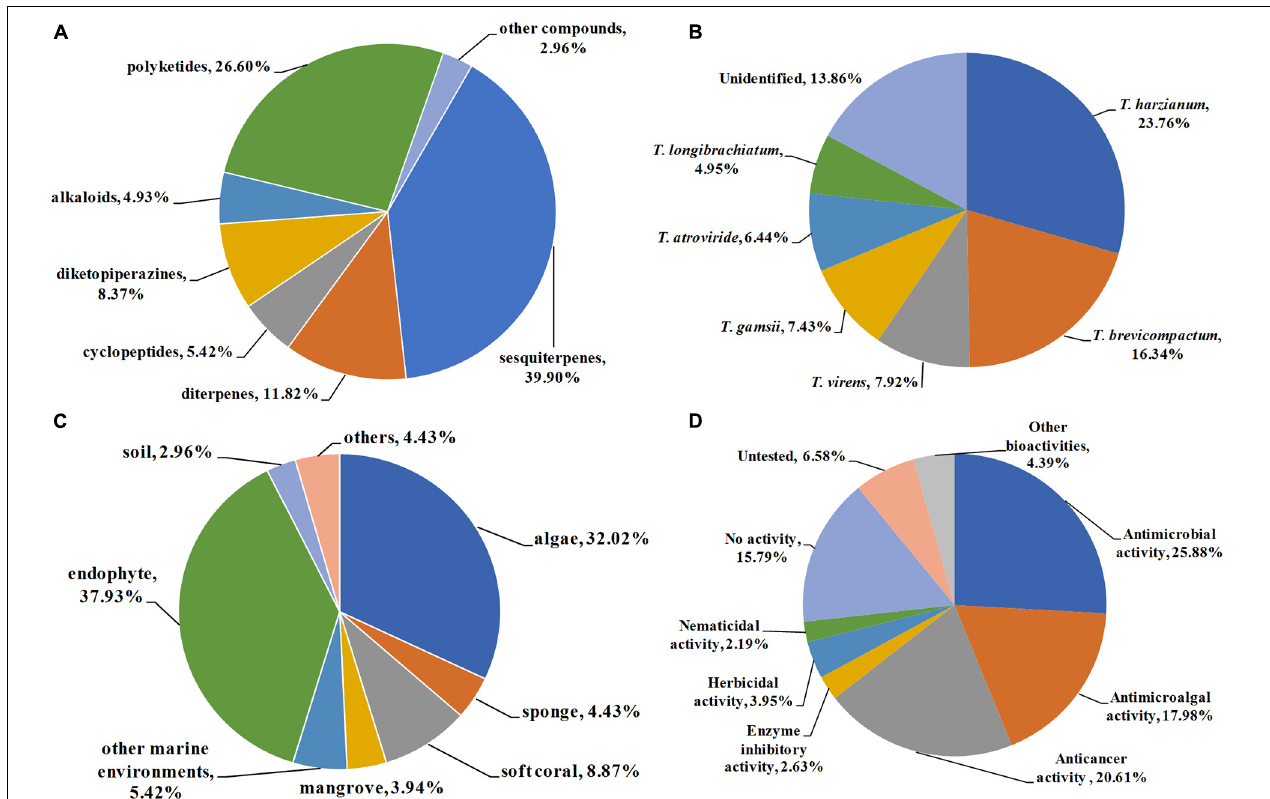
FIGURE 13 | Quantification of this studies. (A) Chemical structures categories; (B) producing strains; (C) environment sources; and (D) bioactivity